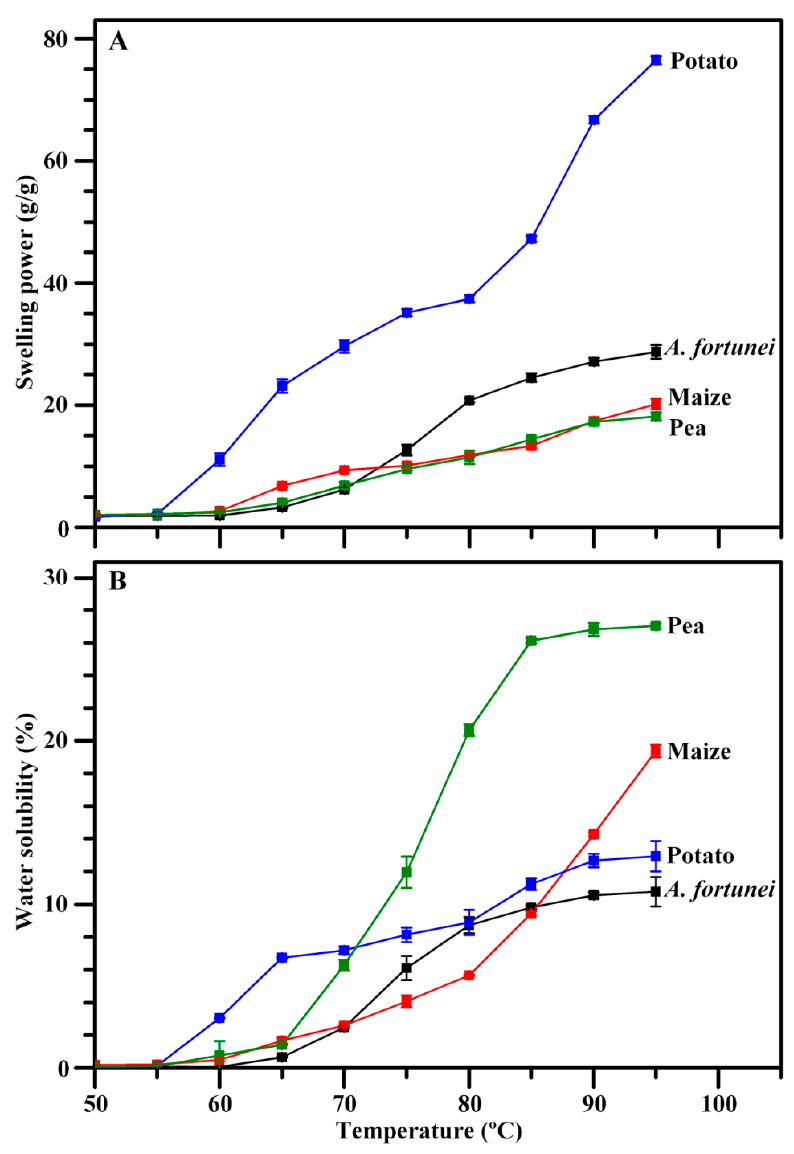
Figure 7. Swelling power ( A ) and water solubility ( B ) of starch.